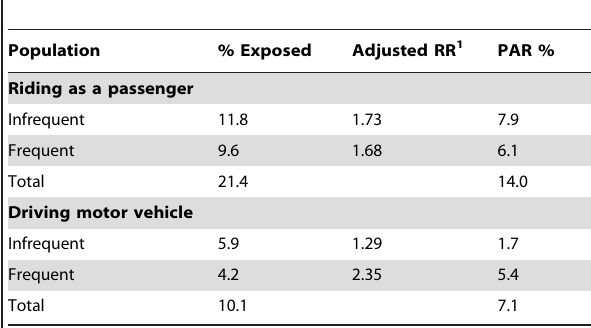
Table 5. Population Attributable Risk Fraction Estimates: 2010 Canadian HBSC